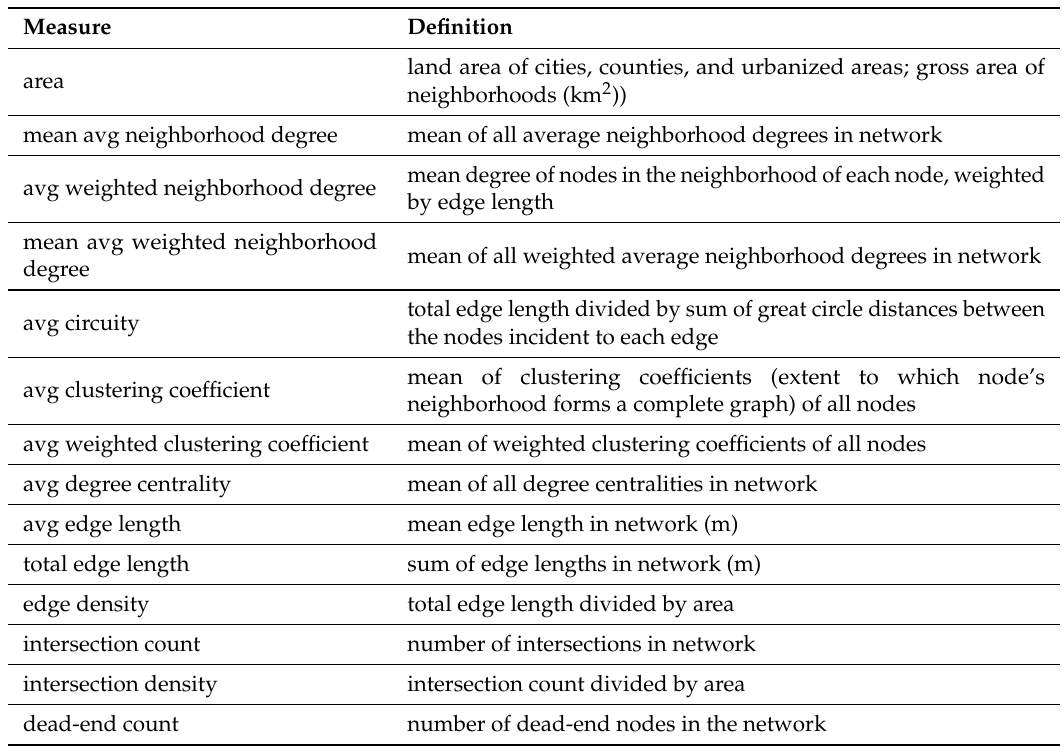
Table 1. Descriptions of network measures in the